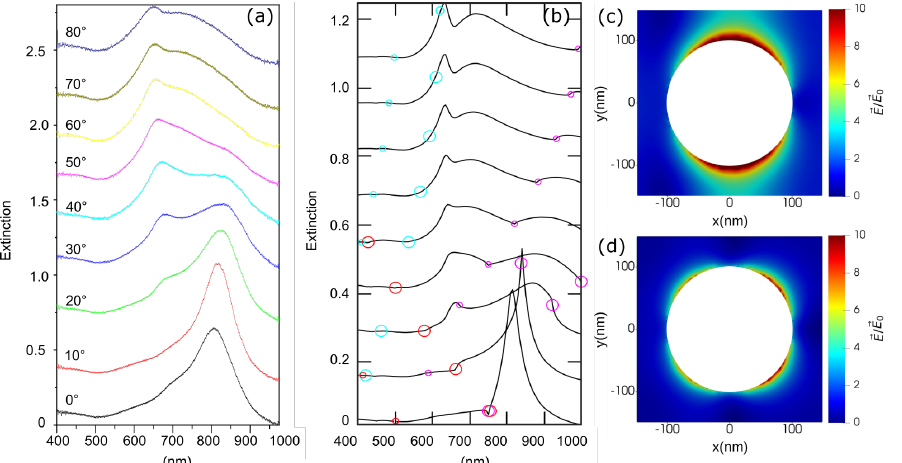
Figure 4. Experimental ( a ) and numerical ( b ) extinction spectra with incidence angle varying from 0 ◦ to 80 ◦ for array having pitch Py = 300 nm and the Px = 500 nm for TE polarization. Electric field distribution calculated 5 nm above the glass substrate for ( c ) θ = 10 ◦ and wavelength of 840 nm, ( d ) for θ = 70 ◦ and wavelength of 630